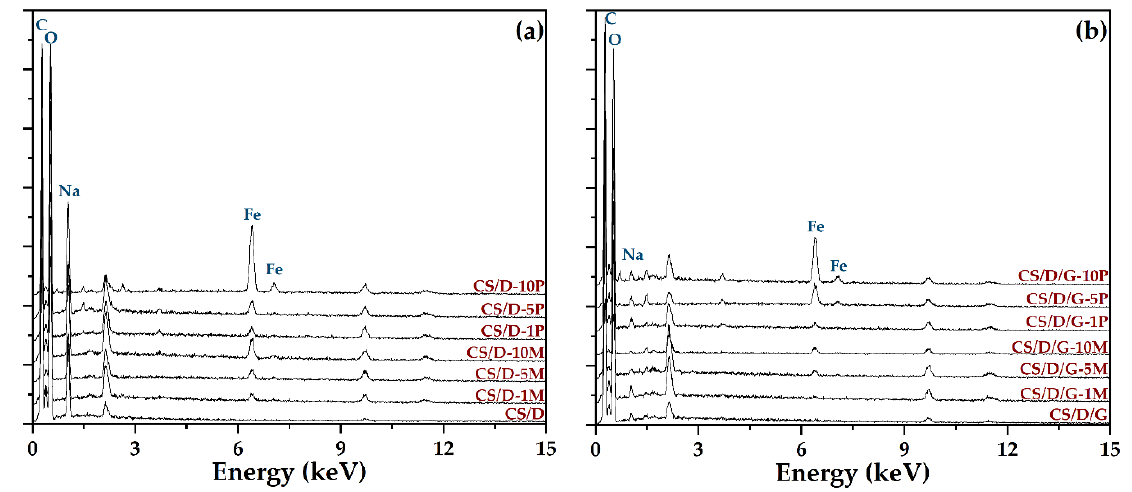
Figure 6. EDX spectra of the CS/D ( a ) and CS/D/G ( b ) hydrogels.